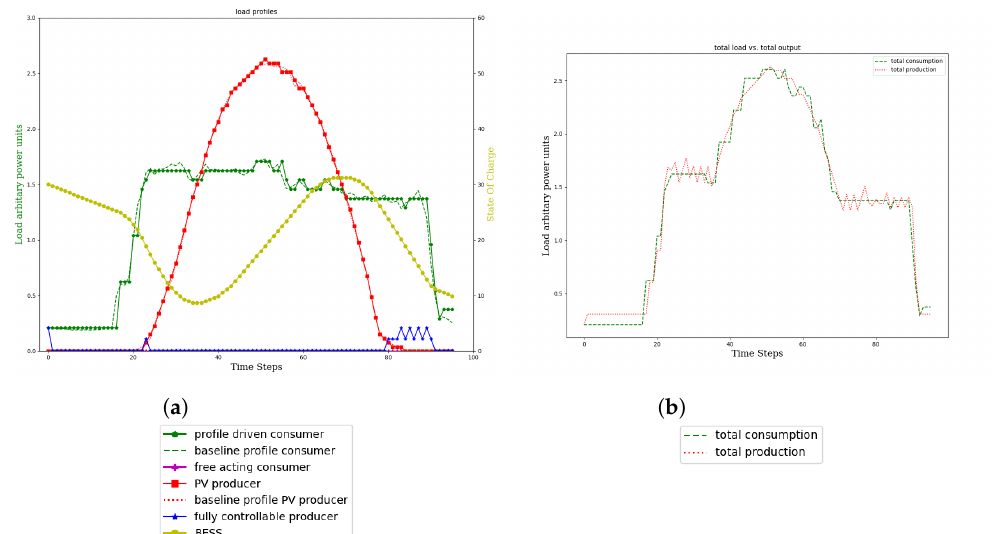
Figure 7. Evaluation on day 1, with agents trained on day 1. ( a ) Agent load curves and profiles. ( b ) Load balancing.